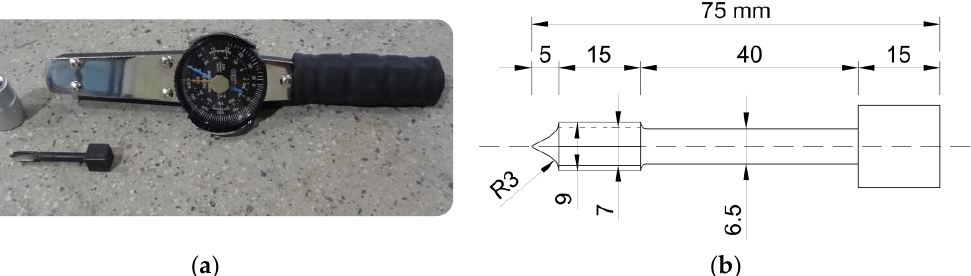
Figure 3. Torque penetrometer: ( a ) complete testing kit used in this article; ( b ) measurements of penetrating nail.